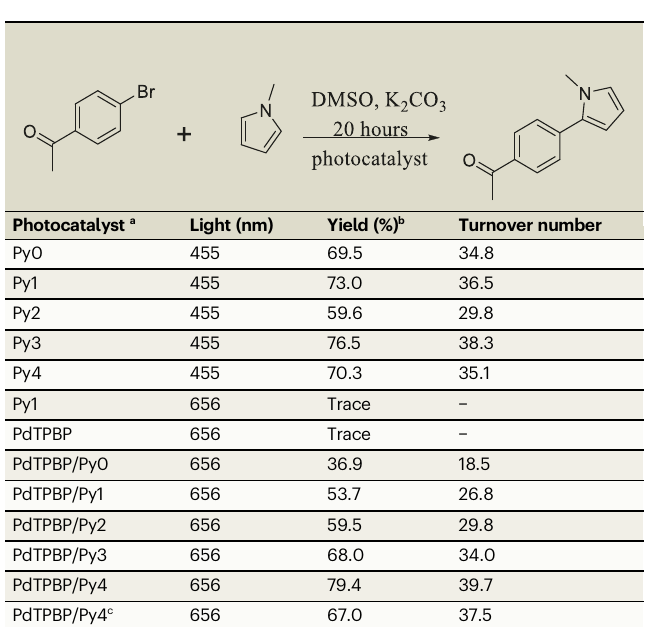
Table 1 | Photoreduction of 4-bromoacetophenone and the cascade coupling with N -methylpyrrole in different